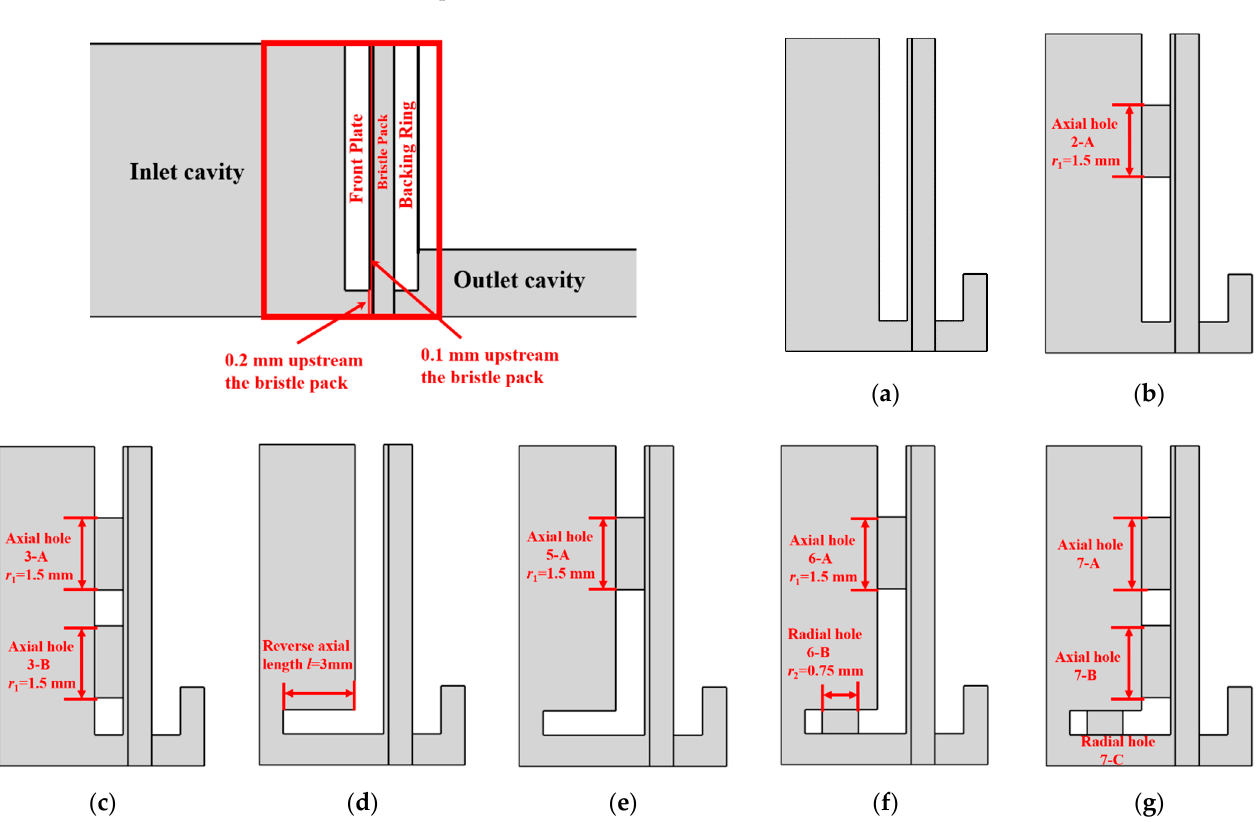
Figure 4. Seven configurations of the front plate: ( a ) Case-1; ( b ) Case-2; ( c ) Case-3; ( d ) Case-4; ( e ) Case-5; ( f ) Case-6; ( g )